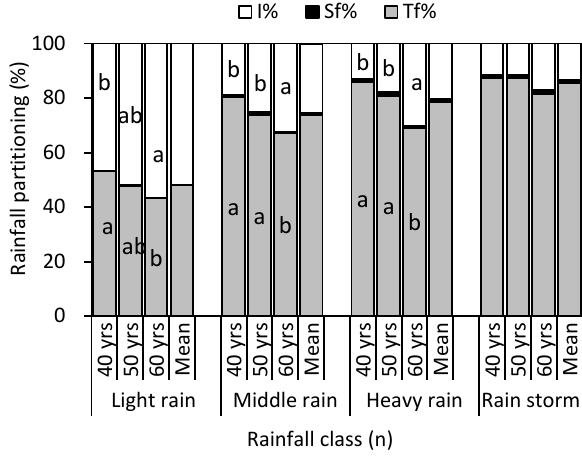
Figure 5. Relative throughfall, stemflow, and interception categorized by rainfall classes for three Chinese pine stand ages. Different letters meant the significant difference ( p < 0.05) among the three stand ages, and the alphabetical order showed the values from the largest to the smallest.